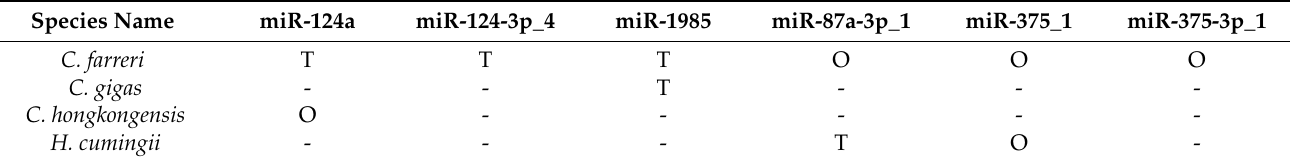
Table 2. Sex preference of six important DEMs in C. farreri and three reported